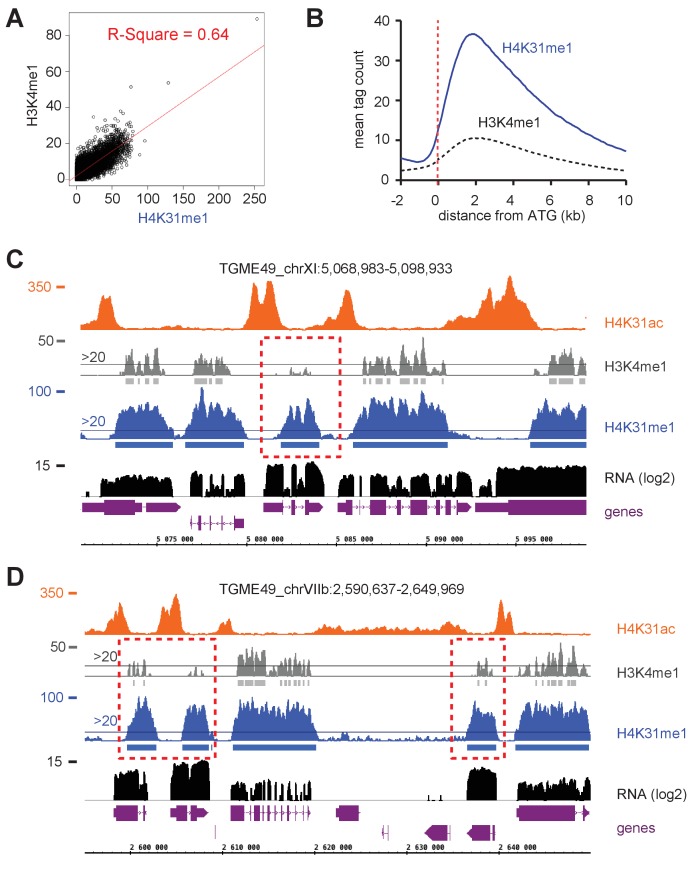
H4K31me1 and H3K4me1 are both enriched in gene bodies in T. gondii.(a) Scatterplot comparing the enrichment difference of H4K31me1 and H3K4me1. The x- and y-axes show the average tag count of the enrichment. (b) Genome-wide correlation of H4K31me1and H3K4me1 enrichment at peri-ATG regions. The average signal profiles of each histone modification were plotted over a −2 kb to +10 kb region with respect to T. gondii genes' ATG. The y-axis shows the average tag count of the enrichment. The vertical dashed line indicates the position of the ATG. (c, d) IGB screenshot of T. gondii Chr. XI (c) and VIIb (d) genomic regions showing reads for various histone marks as well as RNA-seq data (in black). Predicted genes are indicated in magenta along with their putative translated sequence.